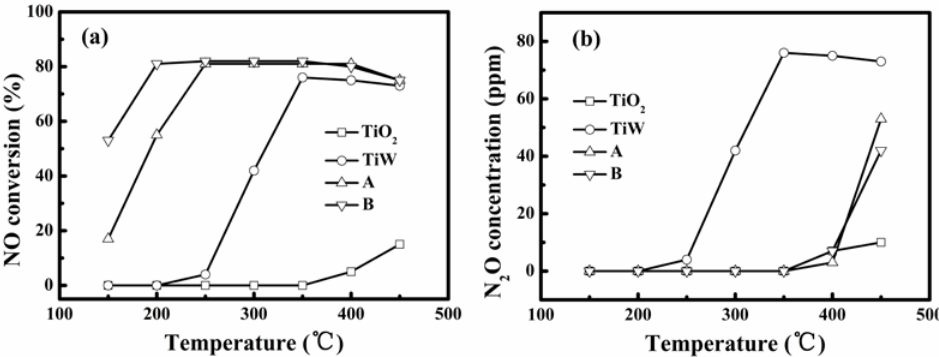
Figure 4. Evaluation for selective catalytic reduction (SCR) of NO at different temperatures over different catalysts: ( a ) NO conversion and ( b ) N 2 O concentration in reacted gas (without SO 2 and water vapor in simulated flue gas and gas conditions in Experimental section).